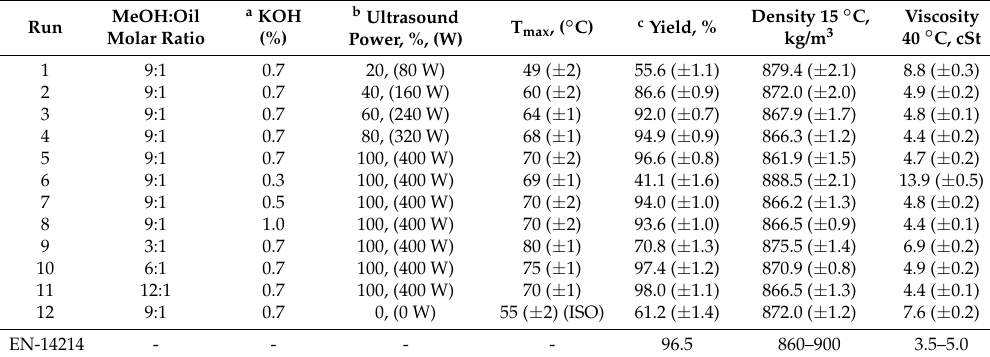
Table 2. Experimental conditions. Properties of biodiesel produced from rapeseed oil and